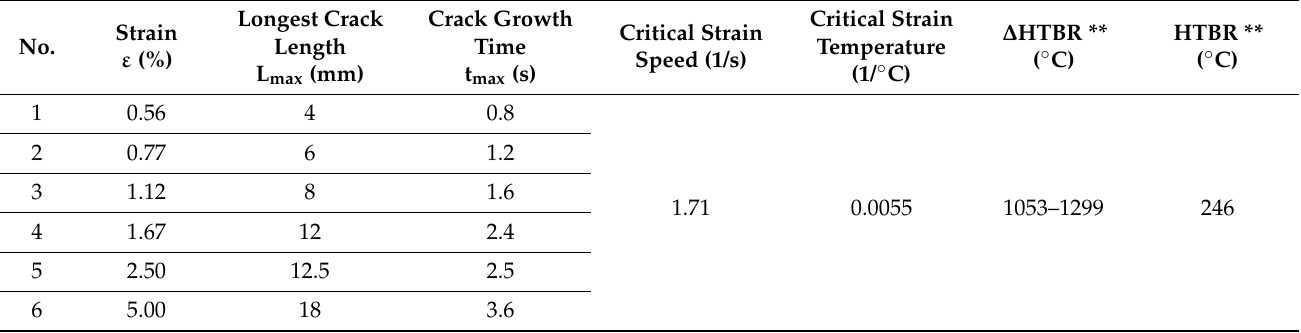
Table 4. Results of the measurements and calculations of the indicators used to assess the high- temperature brittleness range of the Inconel 713C precision castings.